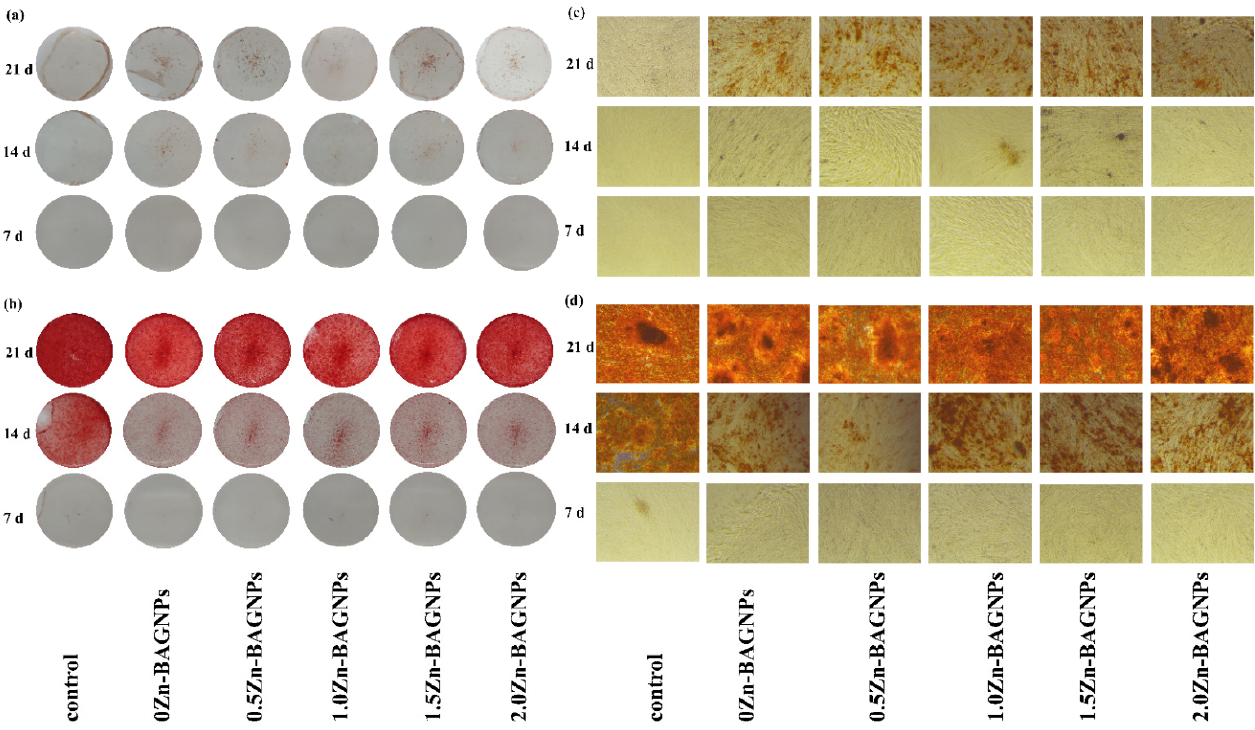
Figure 10. Alizarin red s staining and quantification of exposed PDLSCs with Zn-BAGNPs at the concentration of 250 µg/mL for 1 week, 2 weeks, and 3 weeks under the basal ( a , c ) and osteogenic differentiation media ( b , d ) confirmed calcium deposits in cells.